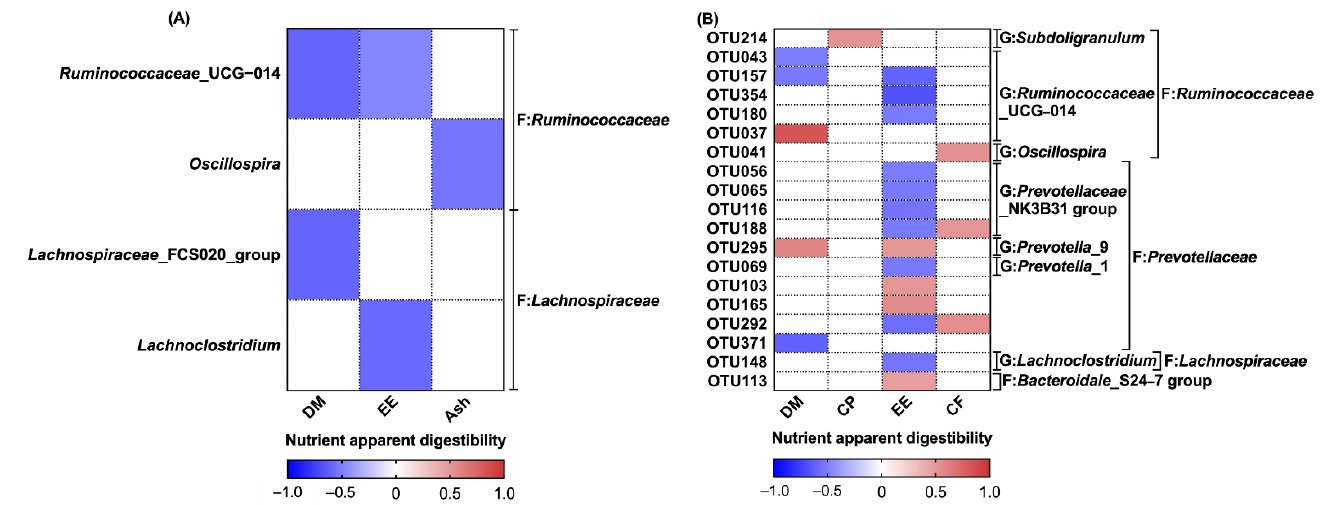
Figure 6. Correlation analysis of fecal microbiota (genus and OTU levels) and apparent nutrient digestibility: ( A ) genus level; ( B ) OTU level. The color indicates the Pearson coefficient distribution: red represents a positive correlation ( p < 0.05), blue represents a negative correlation ( p < 0.05), and white shows that the correlation was not significant ( p > 0.05). F: family; G: genus. At the genus level (Figure 6A), the relative abundance of the Ruminococcaceae _UCG- 014 and Lachnospiraceae _FCS020 groups were negatively correlated with apparent